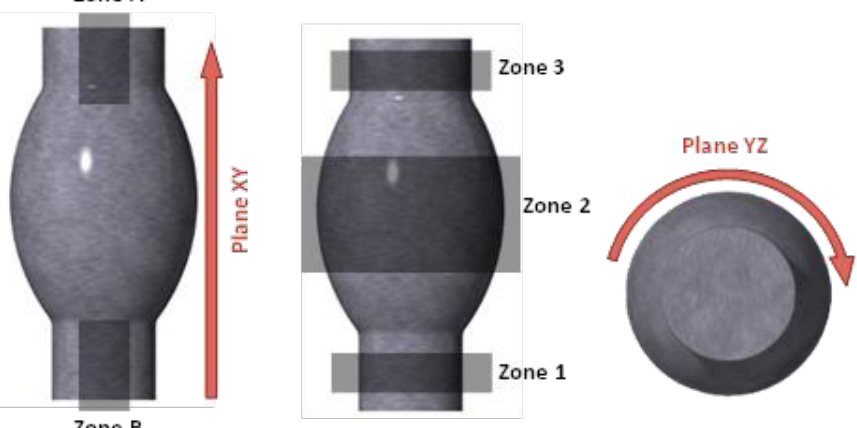
Figure 11. Directions and roughness measurement zones for both parts.